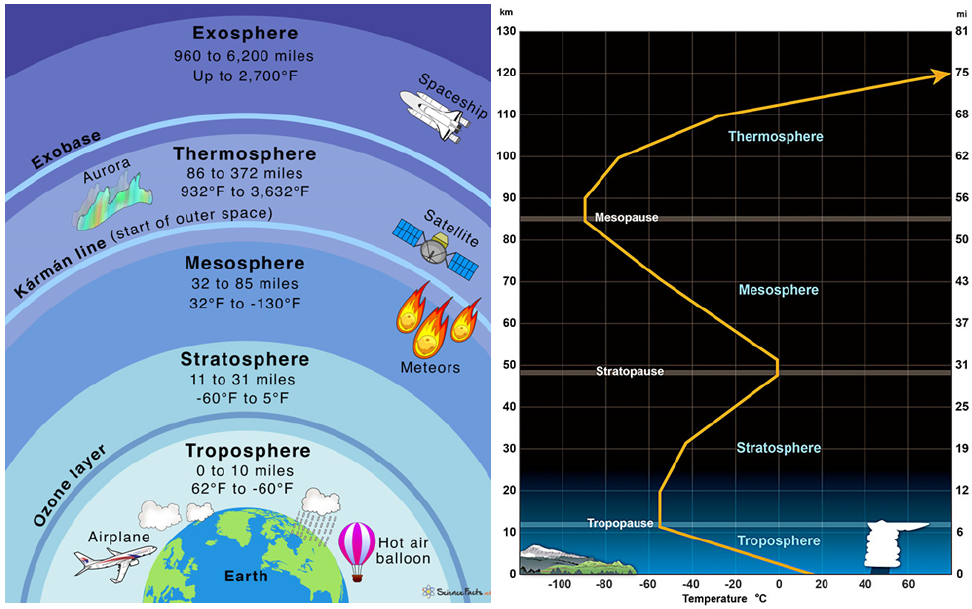
Figure 6. Atmosphere and vertical thermal structure of the Earth